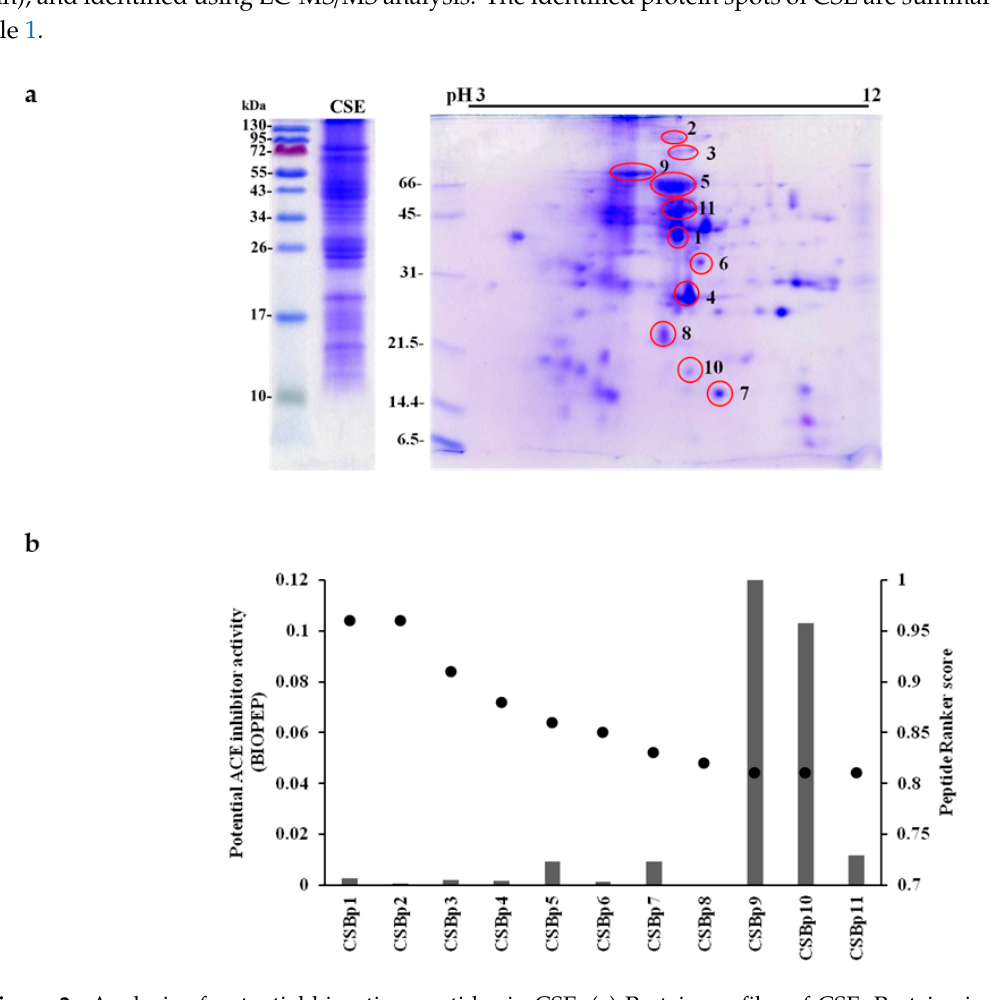
Figure 2. Analysis of potential bioactive peptides in CSE. ( a ) Protein profiles of CSE. Proteins in CSE were separated by SDS-PAGE (left) and 2-DE (right) on 15% polyacrylamide gels. Proteins were visualized by Coomassie Brilliant Blue R-250. Protein spots in red circles were further analyzed by LC-MS / MS. Protein size markers (in kDa) are shown at the left. Photographs are representative images of three independent experiments. ( b ) Prediction of potential bioactive peptides using PeptideRanker and BIOPEP. Dots represent PeptideRanker scores. Bars represent potential ACE inhibitor activity analyzed by BIOPEP.